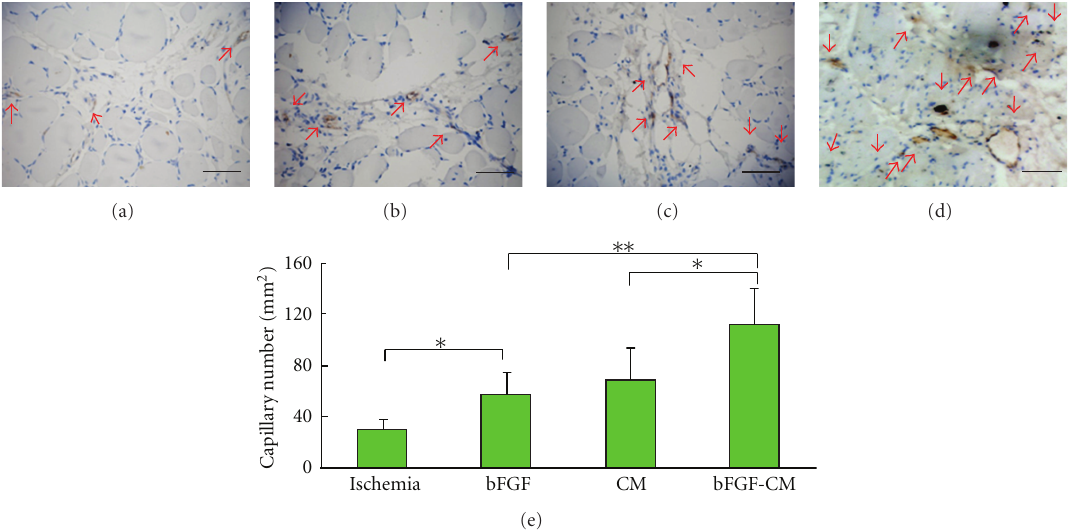
Figure 5: Immunohistochemical analysis for von Willebrand factor in ischemic hindlimbs 4 weeks after implantation. (a) No treatment; (b) bFGF; (c) CM; (d) bFGF-CM (bar = 50 μ m). (e) Histogram of the number of capillaries in the ischemic, bFGF, CM, and bFGF-CM groups ( ∗ P < 0 . 05, ∗∗ P < 0 .